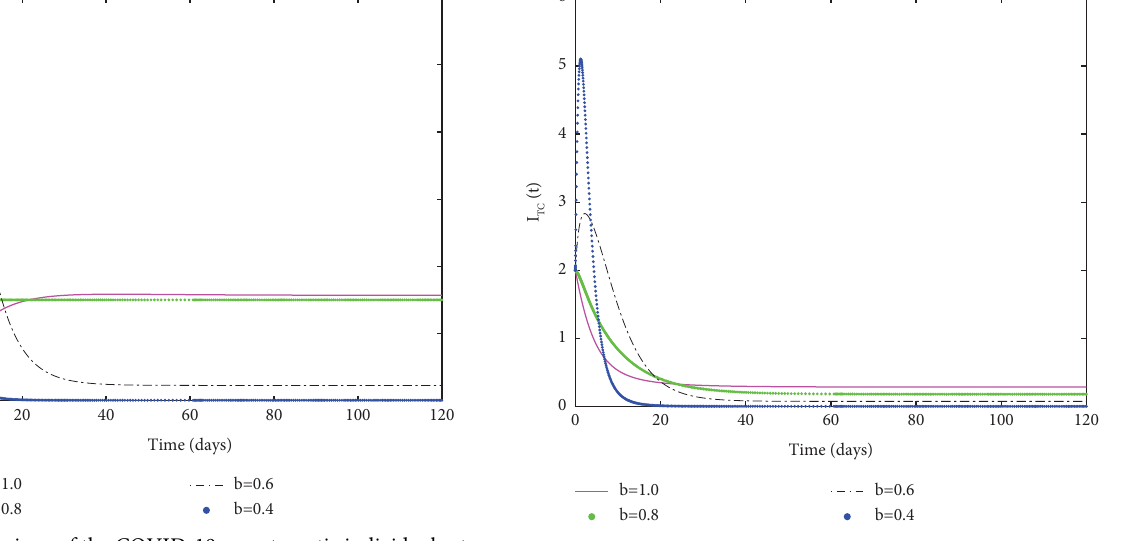
Figure 8: Behaviour of the active TB-COVID-19 coinfected in- dividuals at diferent values of b